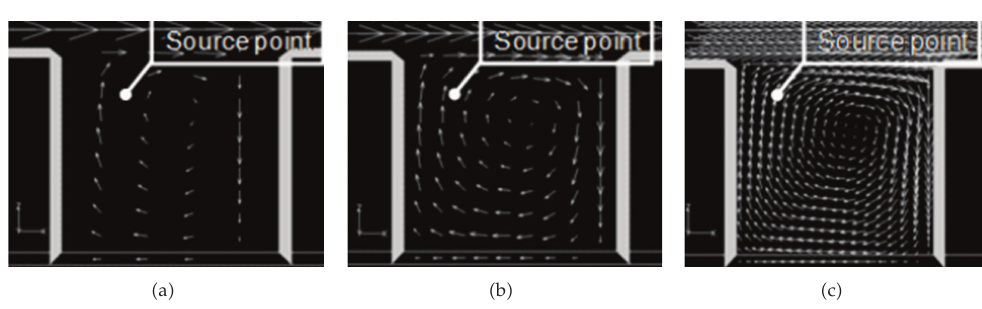
Figure 3: Side view of velocity vector: (cid:3) a (cid:4) Case 1, (cid:3) b (cid:4) Case 2, and (cid:3) c (cid:4) Case 3.